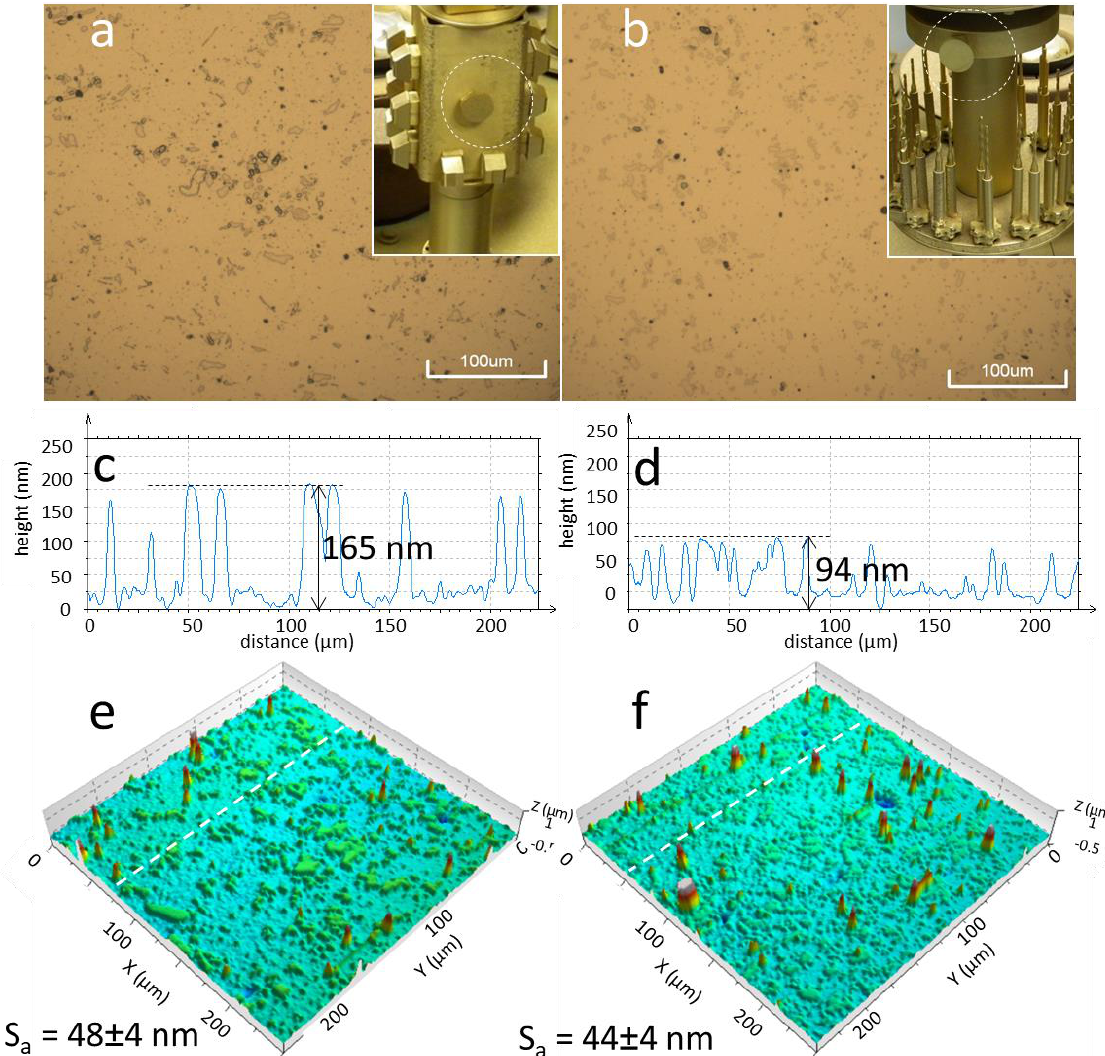
Figure 15. ( a , b ) OM images, ( e , f ) 3D surface profile images and ( c , d ) line profiles (along dashed lines in the Figure ( e , f )) of TiN hard coating deposited on D2 substrate in the BAI deposition system at the same etching and deposition parameters. It is evident that the D2 substrate on the left was exposed to much more intensive ion etching (the step height at the carbide grain is 165 nm) than that right one (the step height at the carbide grain is 94 nm). The reason is the difference in batching configuration (see insets). The surface roughness, however, differs only slightly, due to the higher growth defect density on the right sample (406 defects/mm 2 ) in comparison with the left one (236 defects/mm 2 ). The nodular defects are the sharp peaks.